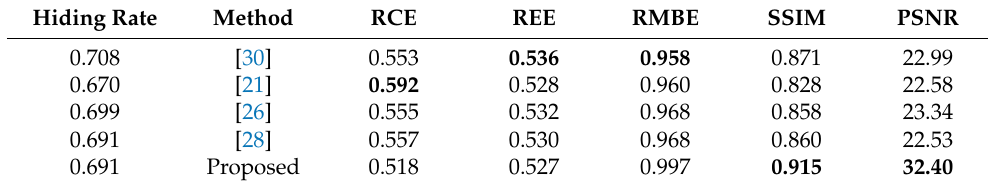
Table 7. Average metrics using the images of Figure 15 F , C = 8.